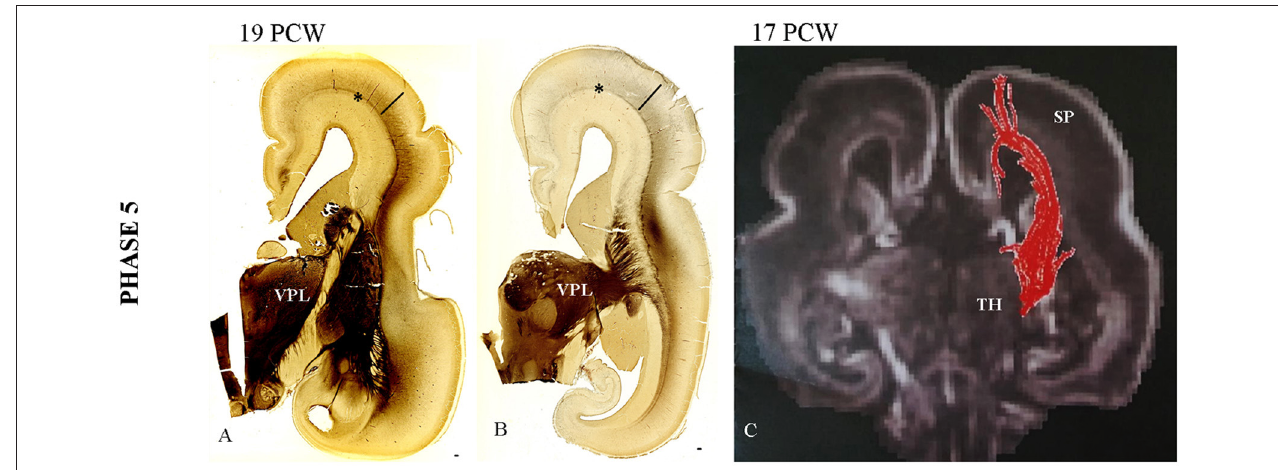
FIGURE 4 | Gradual spread of the AChE-reactivity within the deep subplate at 19 PCW (A). (B) The same process at more caudal level. (C) The DTI extension of the TH-C fibers through SP at 17 PCW. Asterisk marks external capsule; bar marks SP. Scale bar: 100 µ m.